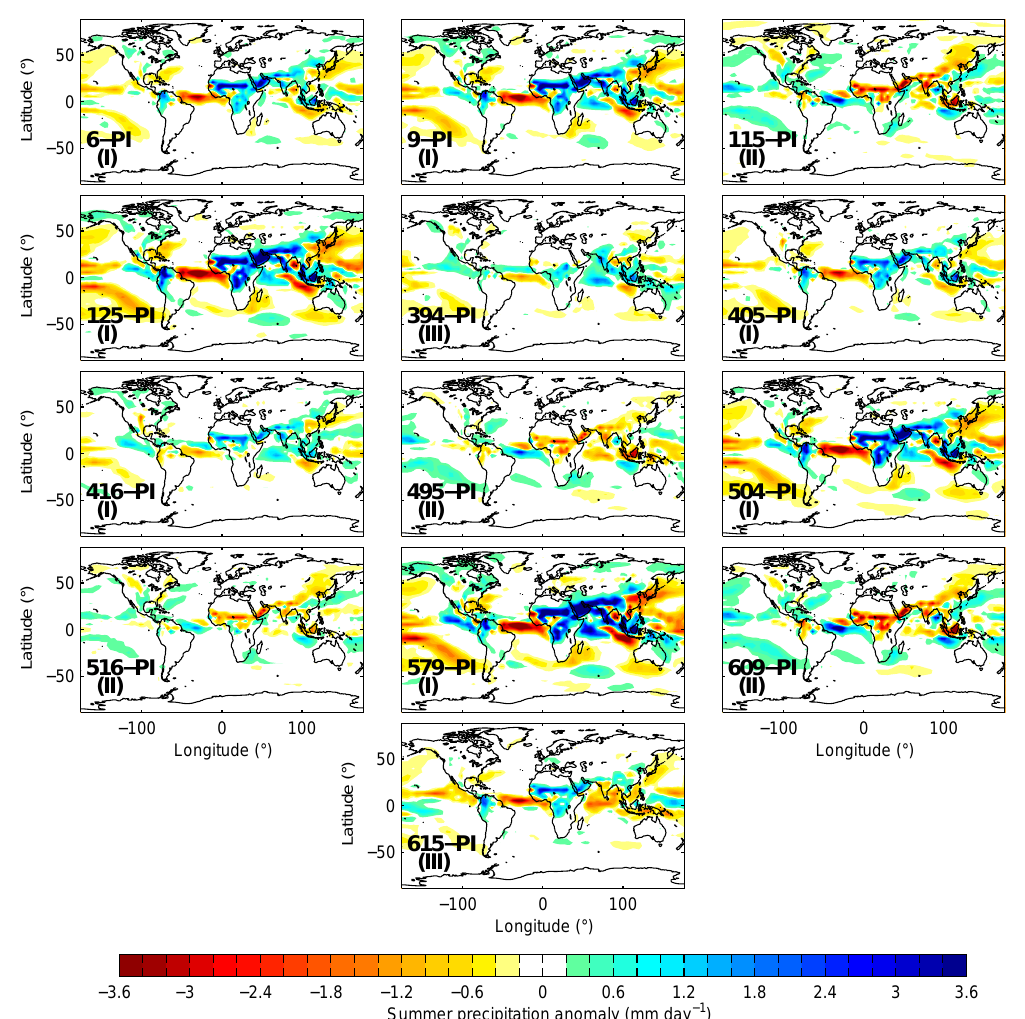
Figure 5. As in Fig. 3, but for boreal summer